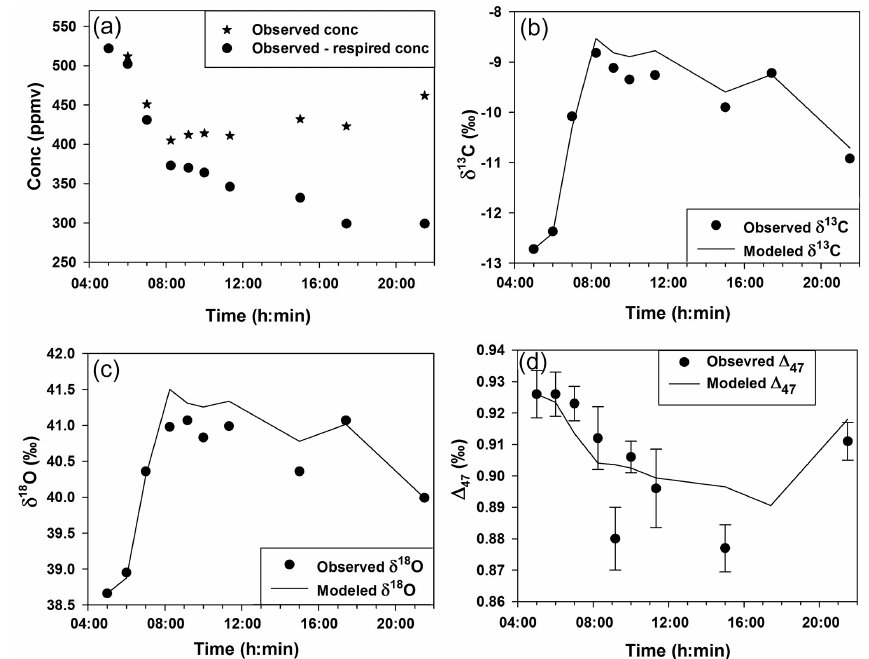
Figure 8. (a) CO 2 concentration inside greenhouse on 31 August 2015: observed concentration (star) and decrease in concentration by photosynthesis after subtracting the respiration (solid circle) are also shown. Comparison of observed (b) δ 13 C, (c) δ 18 O and (d) (cid:49) 47 values with that modeled using discrimination factors of − 16 . 5, − 12 . 0 and 0.065‰ for δ 13 C, δ 18 O and (cid:49) 47 ,